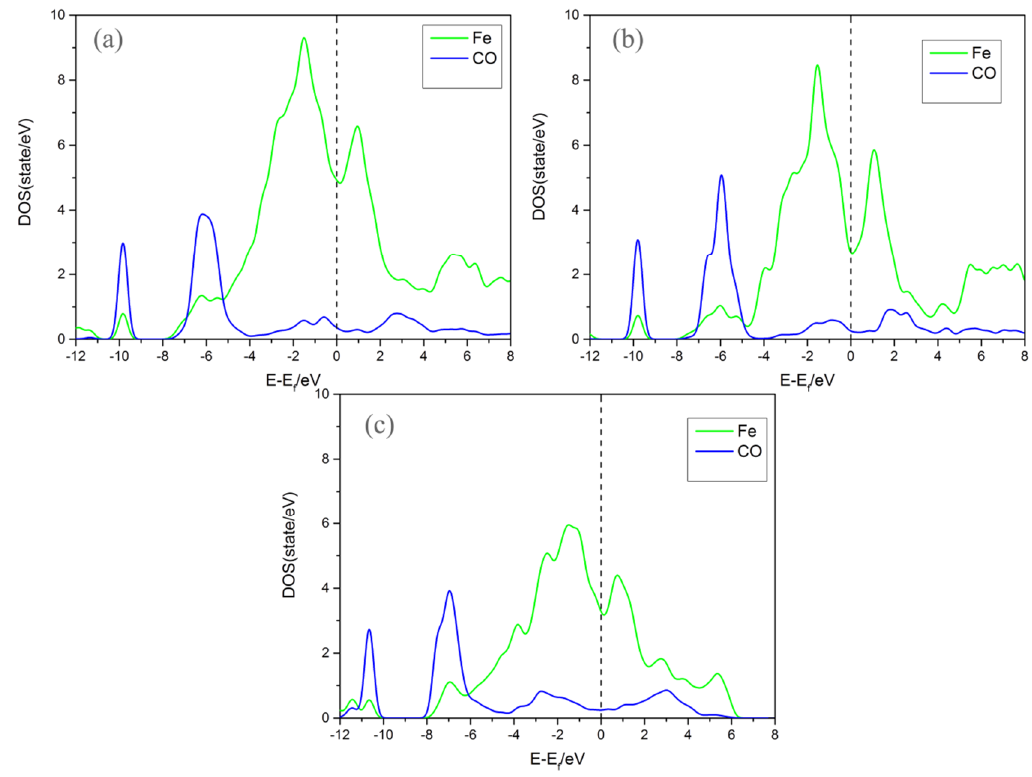
(cid:16) (cid:17) 111 4F3; b . ( 001 ) 3F1; c .